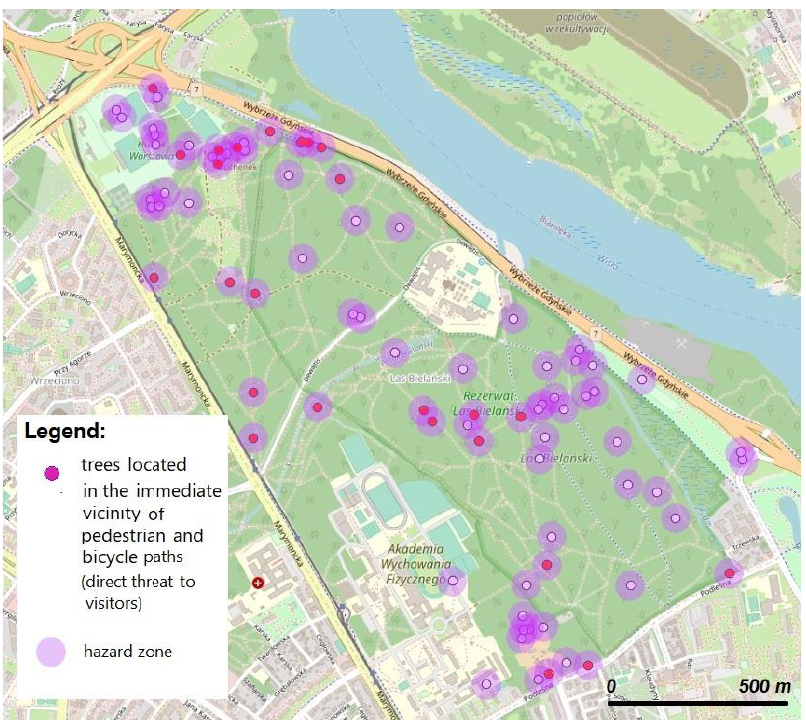
Figure 8. The risk map of the Bielański forest with hazard zones for ill trees (author’s elaboration based on the High Structural Diversity Tree Crown Map database [77]).